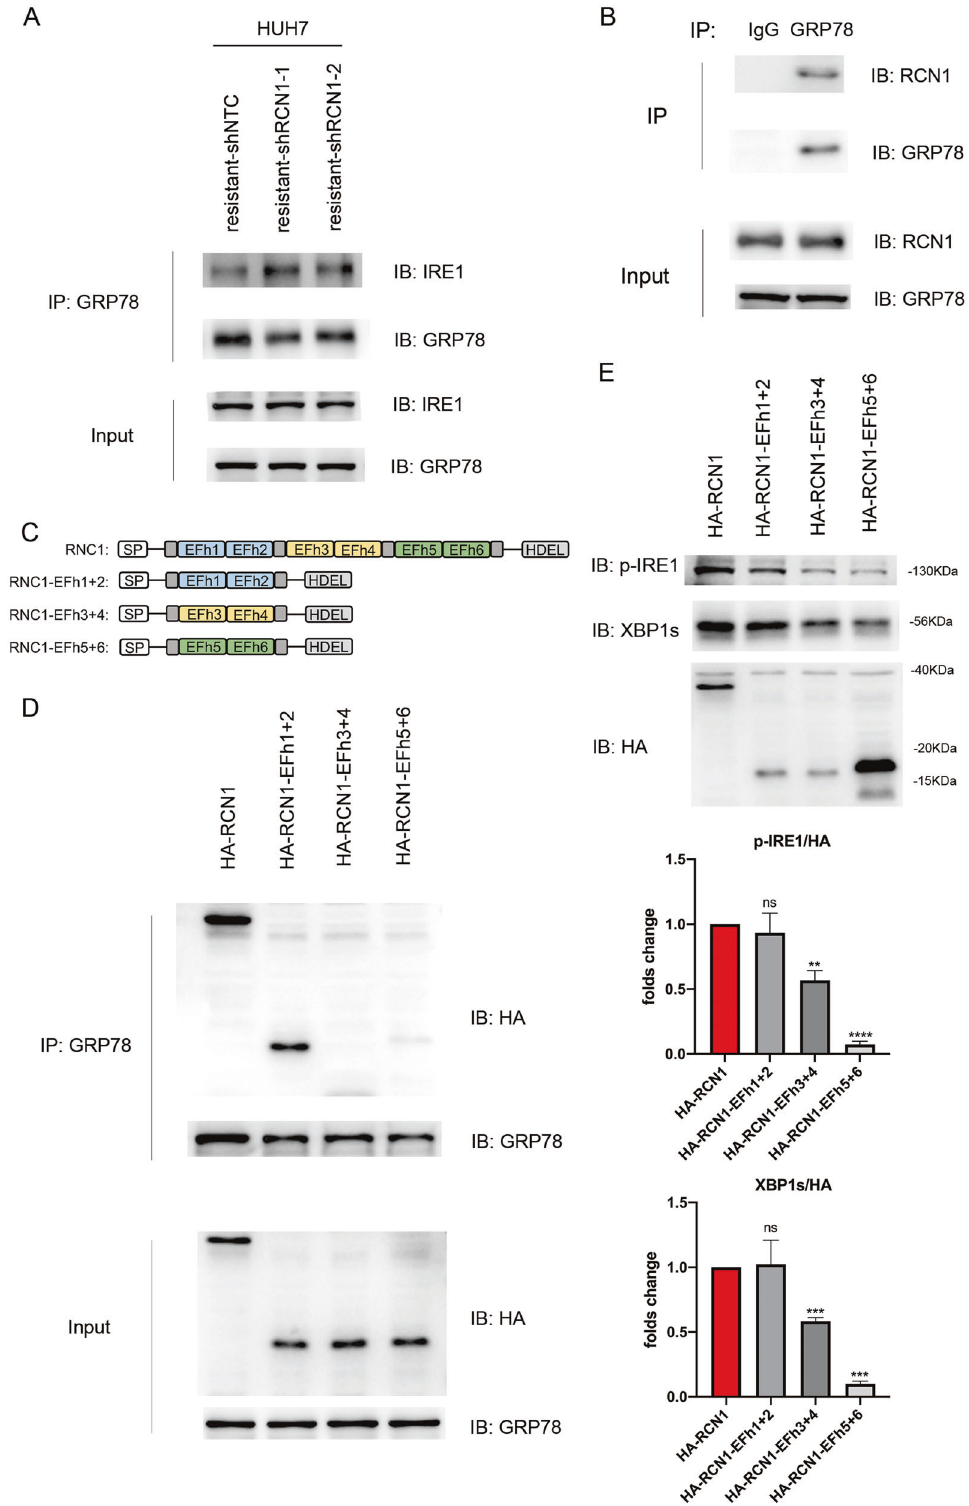
Fig. 5 The RCN1 EFh1/2 domain binds with GRP78 and promotes the dissociation of GRP78 from IRE1. A Immunoblot analysis of the interaction between GRP78 and IRE1 α using immunoprecipitates from sorafenib-resistant Huh7 cells with or without RCN1 silencing. B Immunoblot analysis of complex formation between endogenous RCN1 and GRP78 immunoprecipitated from sorafenib-resistant Huh7 cells. C Schematic representation of the whole-length and deletion RCN1 mutants. D Immunoblot analysis of complex formation between endogenous GRP78 and HA-tagged mutant RCN1. E Immunoblot analysis of IRE1 α phosphorylation and XBP1s protein levels in sorafenib- resistant Huh7 cells transfected with whole-length and deletion RCN1 mutants. Data are presented as the means ± SEM of three independent experiments. ns not signi fi cantly different. ** P < 0.01; *** P < 0.001; **** P < 0.0001, t -test.